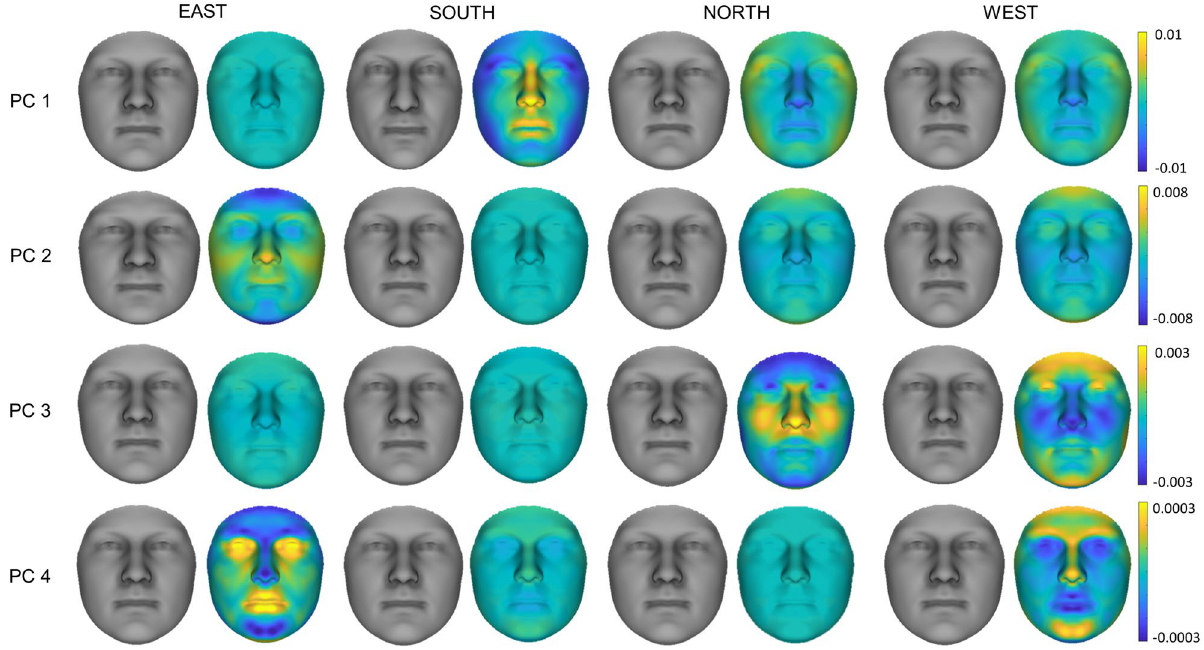
Figure 3. Visual effects of the first four genetic PCs on the facial phenotype representing the four regional populations, North, South, East, and West. Exaggerated faces (8X; shown in grey) and normal displacement maps (magnitude of inward/outward movement) of PC effects on regional faces (n = 186) are shown. Displacement maps are normalized to the same axis per PC for comparison between regions.